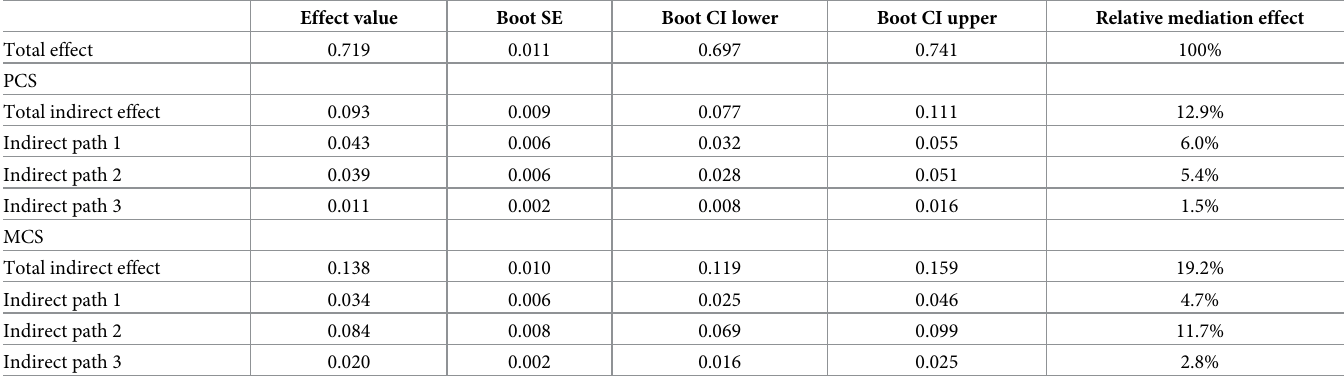
Table 5. The mediating effect of sleep quality and PCS between anxiety and depression.